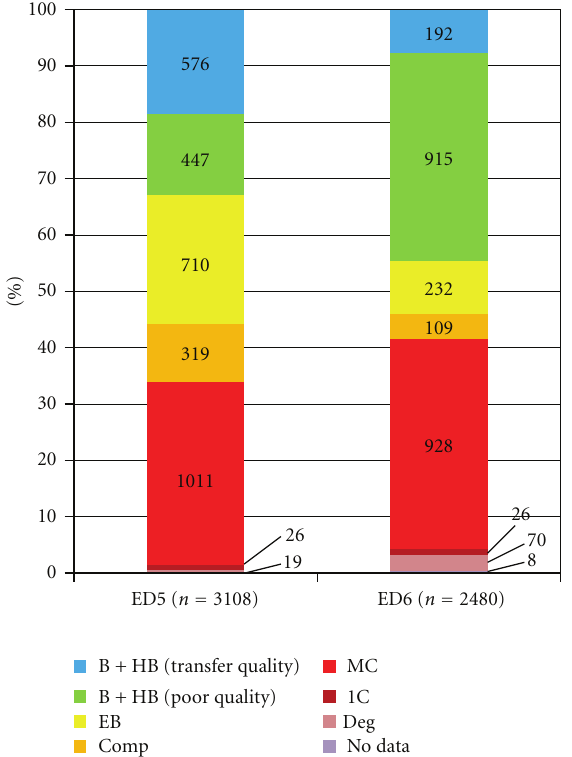
Figure 4: Comparison of embryo morphology on ED5 and ED6. Morphologicalcategories on ED5 and ED6 are shownby percentage in stacked columns. Numbers indicate the number of embryos in each category. HB = hatching blastocyst, B = blastocysts, EB = early blastocyst, comp = compacted, MC = multicell, 1C = one cell, deg =